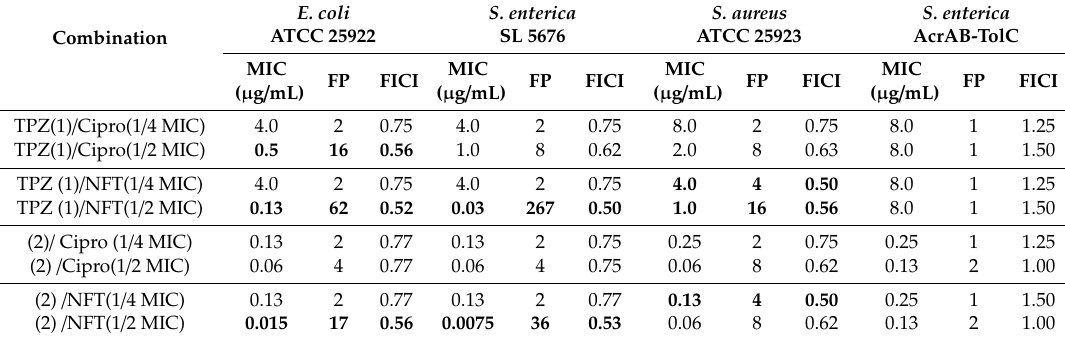
Table 3. The minimum inhibitory concentration (MIC), the fold potentiation (FP) and the fractional inhibitory concentration index (FICI) of TPZ drug ( 1 ) and its most potent derivative (compound 2 ) in combinations with sub-inhibitory concentrations of conventional antibiotics ciprofloxacin (Cipro) and nitrofurantoin (NFT). The strongest combined e ff ects are indicated in bold. E. coli S. enterica ATCC 25922 SL Combination